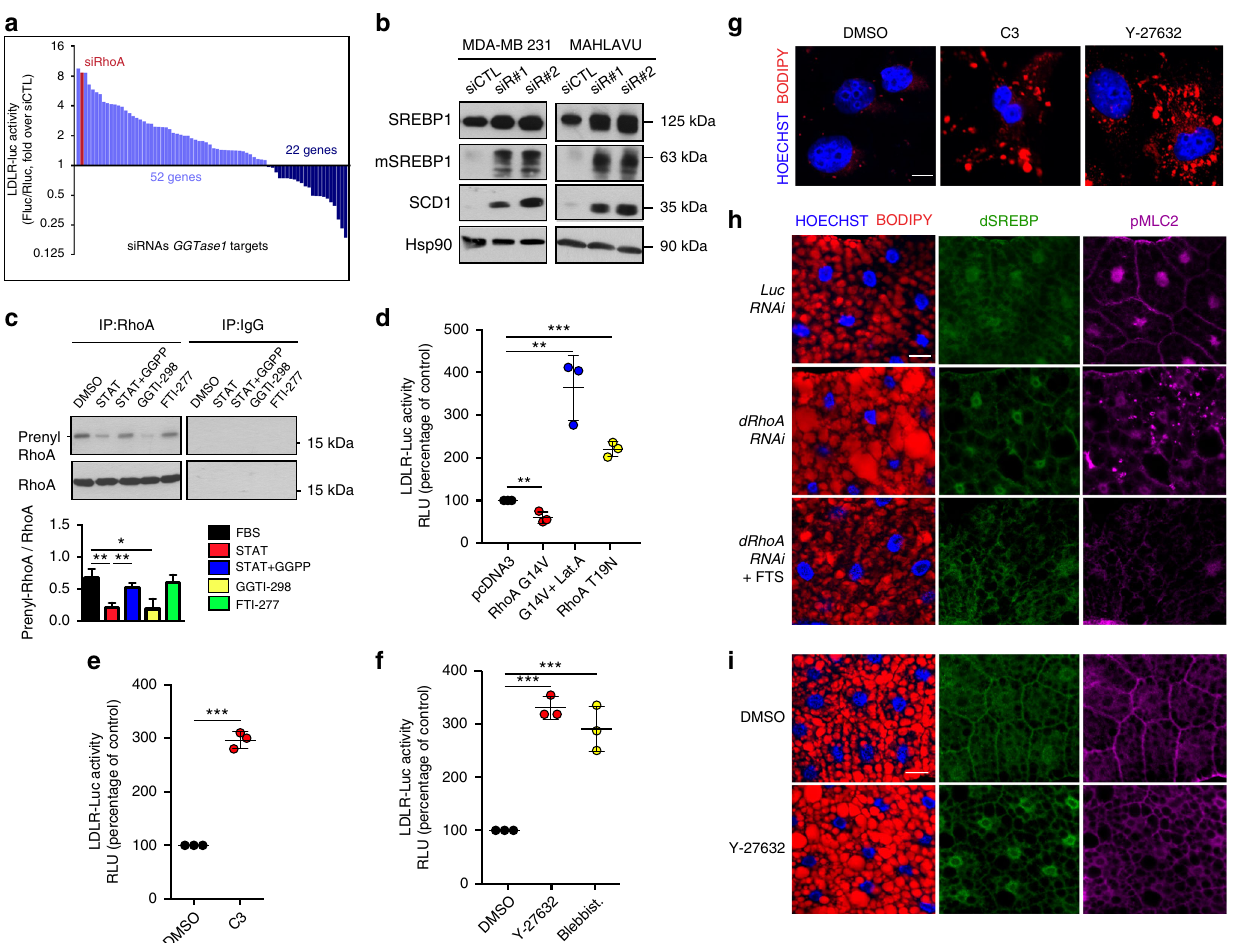
Fig. 2 RhoA and acto-myosin regulate the activity of hSREBP1 and dSREBP. a Screening of low density lipoprotein receptor promoter-luciferase activity in MDA-MB-231 cells transfected with constructs expressing fi re fl y (LDLR-Luc) and renilla (Rluc) luciferase and either control siRNA (siCTL) or siRNAs targeting genes encoding geranylgeranyl pyrophosphate transferase I (GGTase1) protein substrates. b Western blot analysis of MDA-MB-231 and Mahlavu cells 48 h after transfection with siCTL or RhoA targeting siRNAs (siR#1 and siR#2). Hsp90 was used as loading control. mSREBP indicates mature protein. c Western blot analyses of immunoprecipitated (IP) RhoA in MCF-10A cells treated DMSO (as control), 1 μ M cerivastatin (STAT), 1 μ M cerivastatin and 20 μ M GGPP (STAT + GGPP), 5 μ M GGTI-298 or 5 μ M FTI-277. IgGs were used as IP control. d LDLR-Luc assay in MCF-10A cells 12 h after transfection with pcDNA3-GFP control plasmid, pcDNA3-GFP-RhoA G14V construct with a 6 h DMSO treatment, pcDNA3-GFP-RhoA G14V construct with a 6 h Latrunculin A (G14V + Lat.A) treatment, or pcDNA3-GFP-RhoA T19N construct. e LDLR-Luc assay in MCF-10A cells treated with either DMSO as control or C3 for 24 h. f LDLR-Luc assay in MCF-10A cells treated with either DMSO as control, Y-27632, or Blebbistatin (Blebbist.) for 24 h. g BODIPY 493/ 503 staining of lipid droplets (in red) in Mahlavu cells treated with either DMSO, C3 or Y-27632 for 24 h. Scale bar, 15 μ m. h , i BODIPY 493/503 staining of lipid droplets (in red) and immuno fl uorescence analysis of dSREBP (in green) and phosphorylated myosin light chain (pMLC2, in magenta) in Drosophila larval fat body from h fl ies expressing either Luciferase or dRhoA RNAi , or dRhoA RNAi and treated with fatostatin (FTS) and i wild-type fl ies treated with either DMSO or Y-27632. Scale bar, 20 μ m. Graphs bars in ( c – f ) represent mean ± s.d. of n = 3 biological replicates. Values in ( d – f ) are expressed as Relative Luminometer Units (RLU). Nuclei in ( h – i ) were stained with HOECHST (in blue). Blots and images are representative of n = 3 biological replicates. P value: * P < 0.05, ** P < 0.01, *** P < 0.001 by two-tailed Student ’ s t -test for all analyses dominant negative RhoA T19N (Supplementary Fig. 2g) caused epithelial breast cells with either the ROCK inhibitor Y-27632 LDLR-Luc (Fig. 2d and Supplementary Fig. 2h) and SCD1-Luc or the myosin inhibitor Blebbistatin and monitored SREBP1 activation (Supplementary Fig. 2i). Accordingly, RhoA inhibition by transcriptional activity. Both treatments activated SREBP1, as C3 toxin caused LDLR-Luc (Fig. 2e and Supplementary Fig. 2j) and shown by induction of either LDLR-Luc (Fig. 2f and Supple- SCD1-Luc activation (Supplementary Fig. 2k) and induction of mentary Fig. 2j) or SCD1-Luc reporter activity (Supplementary LDLR , SCD1 and HMGCR mRNA expression (Supplementary Fig. 2k), and by LDLR , SCD1, ACC1, FASN and HMGCR mRNA Fig. 2l). expression (Supplementary Fig. 2l). Moreover, the effect of RhoA Upon geranylgeranylation, RhoA localizes at the plasma overexpression on SREBP1 activation was abolished by inhibition membrane and triggers actin polymerisation and acto-myosin of actin polymerisation with Latrunculin A treatment (Fig. 2d and contraction, via activation of its downstream effector Rho-kinase Supplementary Fig. 2h, i), thus demonstrating that actin (ROCK) 15 , which phosphorylates the myosin light chain 2 polymerisation acts downstream of RhoA/ROCK signalling to (MLC2). To test whether the regulation of SREBP1 by RhoA control SREBP1 activation. Furthermore, inhibition of either requires the canonical ROCK pathway, we treated human RhoA or ROCK induced a massive accumulation of lipid droplets NATURE COMMUNICATIONS| (2019) 10:1326